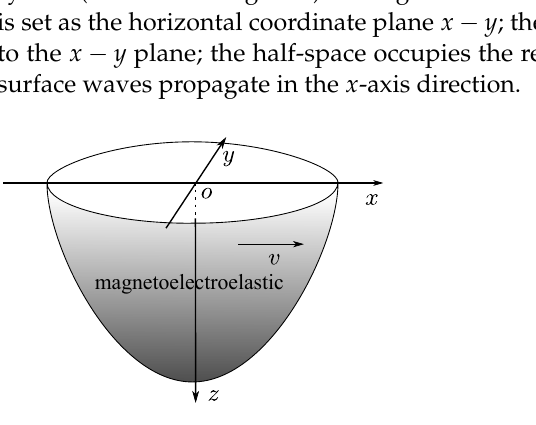
Figure 1. A nonhomogeneous magneto-electro-elastic half-space showing in the coordinate